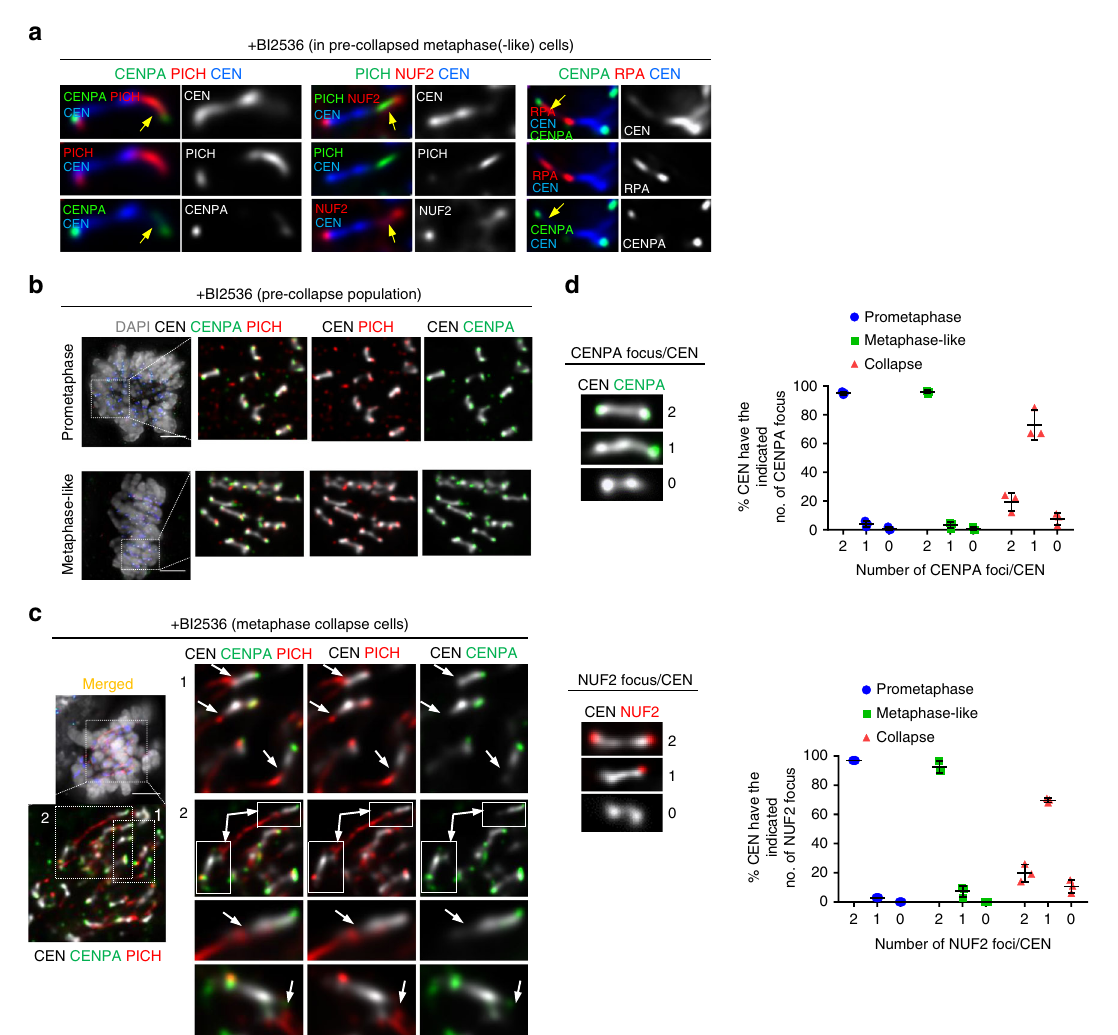
Fig. 5 Loss of kinetochore attachment at centromeres after dislocation. a Representative images showing the kinetochore complex detaches from the core centromere, whilst remaining connected by PICH- or RPA-coated DNA threads (arrows) in BI2536-treated metaphase-like RPE1 cells. Inner and outer kinetochores were labelled by CENPA and NUF2, respectively. b Examples showing the majority of centromeres retain two kinetochores in pre-collapsed mitotic populations (prometaphase and metaphase-like cells) after BI2536 treatment. c Representative image showing the metaphase-collapse cells losing kinetochore complex at one side of the centromere. Note: the side without the kinetochore is concomitant with the formation of PICH-associated DNA linkages (arrows). Enlarged images (1 and 2) highlight the loss of CENPA signal at regions of where PICH-decorated DNA linkages form (arrows). d Quanti fi cation of the numbers of CENPA- and NUF2-labelled kinetochores at centromeres in prometaphase, metaphase-like and collapse stages after BI2536 treatment ( n = 3 independent experiments analysing a total of 3020 CENPA-labelled centromeres and 3625 NUF2-labelled centromeres; mean ± S. D. is shown). Note: all RPE1 cells analysed were pre-synchronised at G1/S by single thymidine block. Drugs were added at 6 h post-release. After 2 h treatment, cells were subject to immuno fl uorescence staining. Scale bars = 5 μ